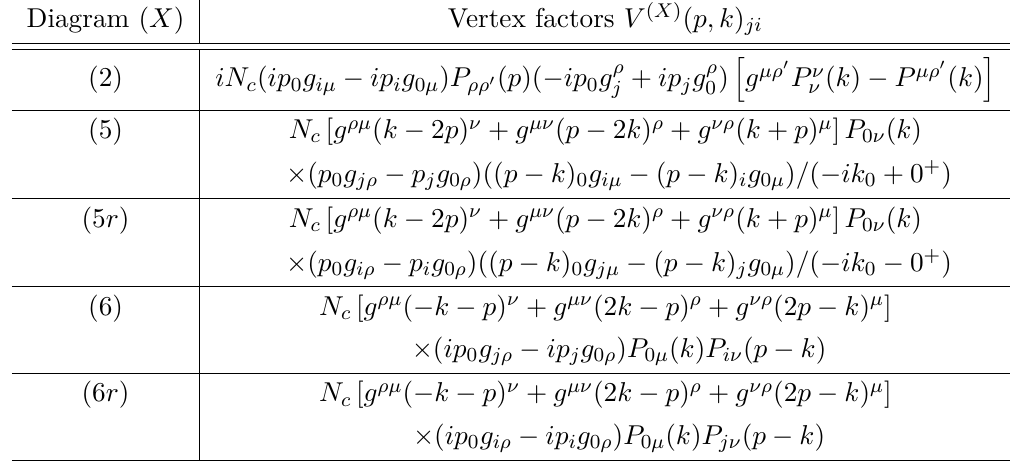
(cid:2) (cid:3) da g ++ . E ji,JI